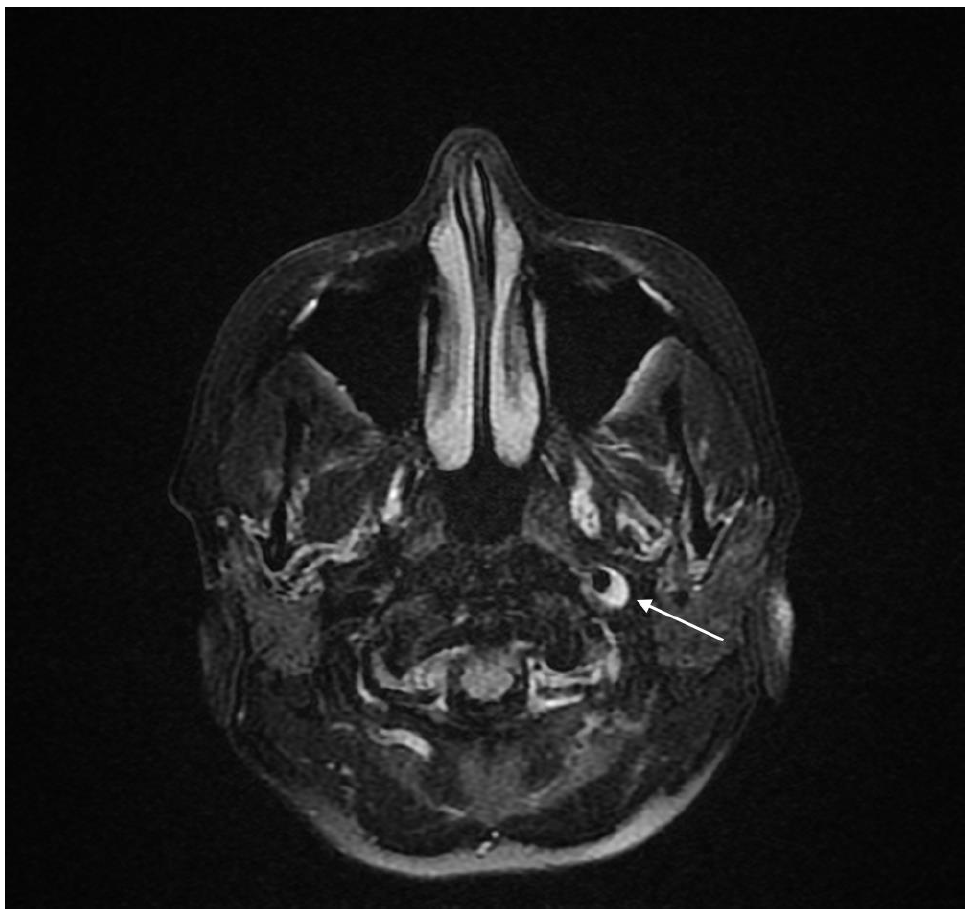
Figure 1. Baseline MRI of the brain. Axial fat-saturated FLAIR image clearly demonstrating an intramural thrombus in the left ICA (marked with an arrow).